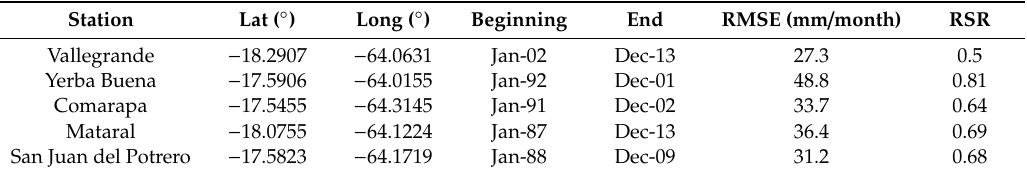
Table 10. Values of root mean squared error (RMSE) and RMSE-observations standard deviation ratio (RSR) utilized for the validation of the Climate Hazards Group Infrared Precipitation with Stations (CHIRPS) dataset in the study area for the selected validation stations. The data from Vallegrande were used to generate the CHIRPS database value of rainfall.